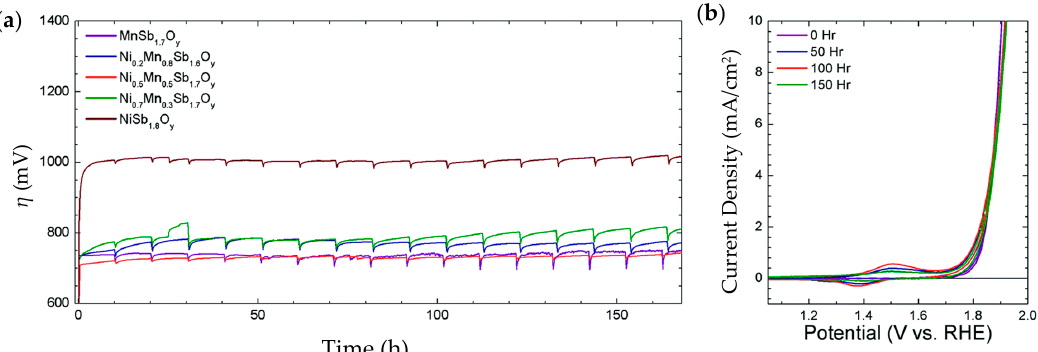
Figure 18. ( a ) Stability of the Ni 0.5 Mn 0.5 Sb 1.7 O y electrodes at 10 mA/cm 2 in 1 M H 2 SO 4 ; ( b ) Cyclic voltammetry at 10 mV/s in between the stability test. Reprinted with permission from [202]. Copyright 2017 The Royal Society of Chemistry.